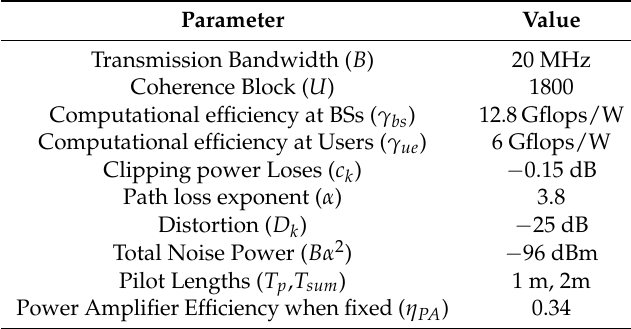
Table 1. Simulation parameters.